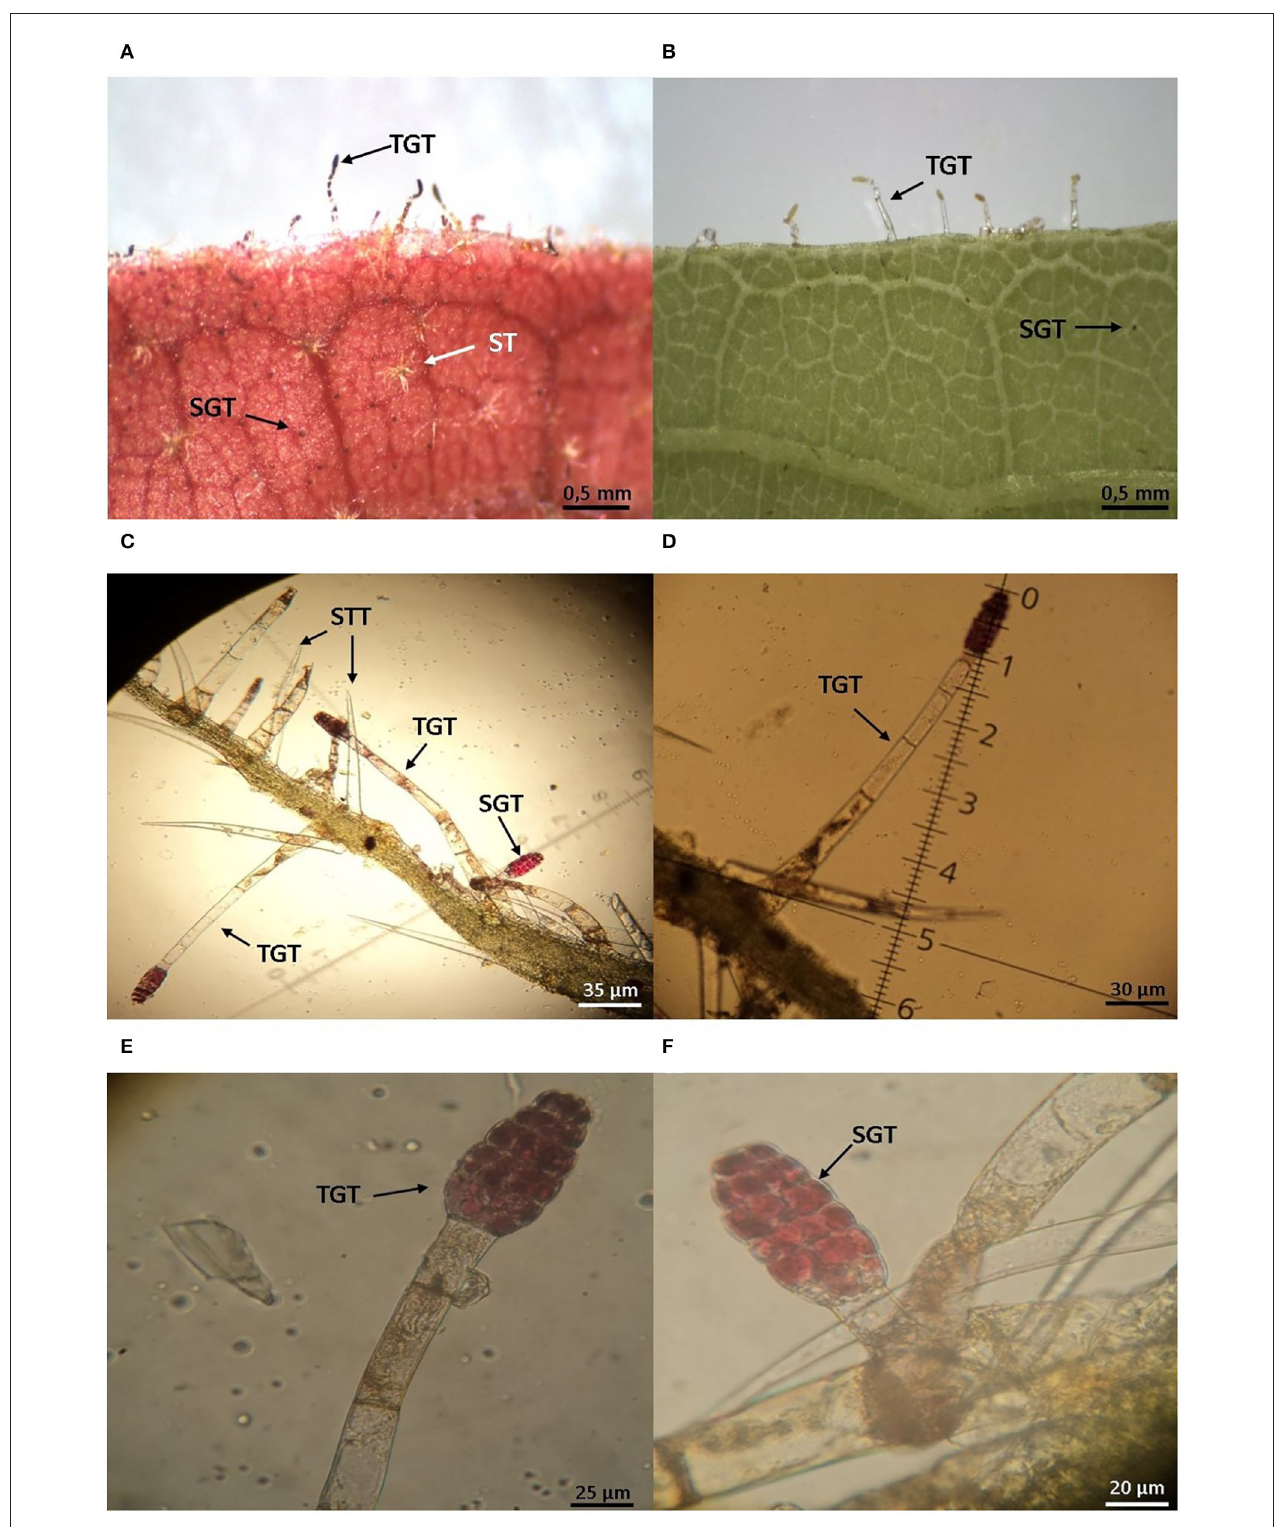
FIGURE 4 | Morphology of trichomes on the Theobroma cacao phylloplane. (A) Distribution of simple (STT), stellate (ST), tall (long up to 5mm) glandular (TGT), and short (measuring about 1mm) glandular (SGT) trichomes on the abaxial leaf surface of resistant cocoa genotype to M. perniciosa (CCN51). (B) Susceptible cocoa genotype to M. perniciosa (Catongo). (C) Paradermal section of the leaf blade at the level of the central rib. (D) Magnifications of TGT. (E,F) TGT and SGT in young leaves of the resistant cocoa genotype (CCN51) containing bio-active molecules, respectively.